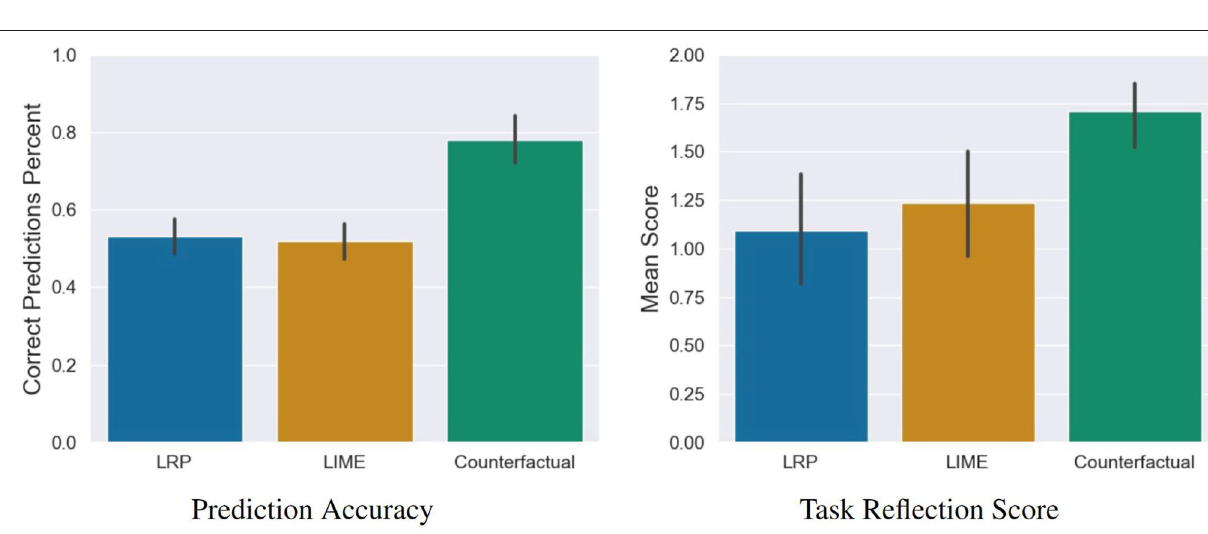
used post-hoc comparisons for each variable 5 .